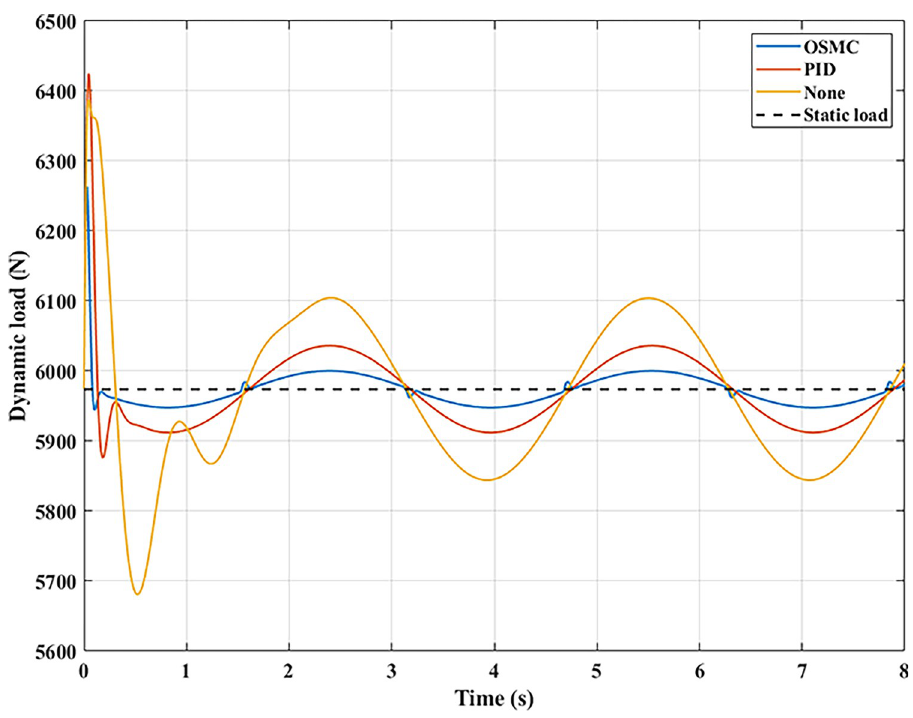
Fig 13. Dynamic load (case 1).